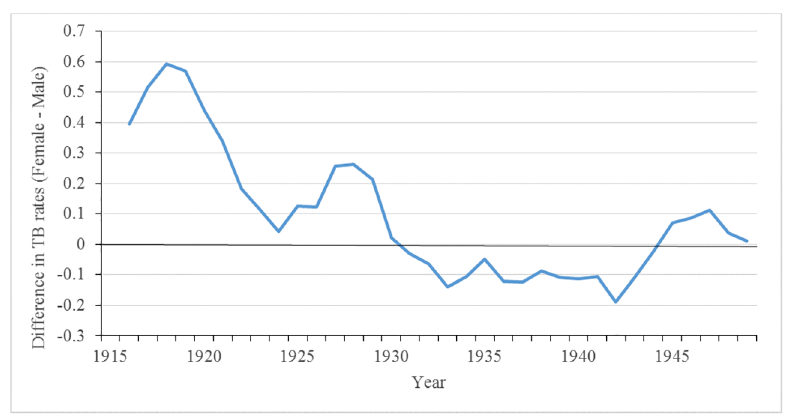
Fig 9. Absolute sex differences in tuberculosis mortality rates: 1911–1949 * . * difference is = Female TB mortality rate- Male TB mortality rate.